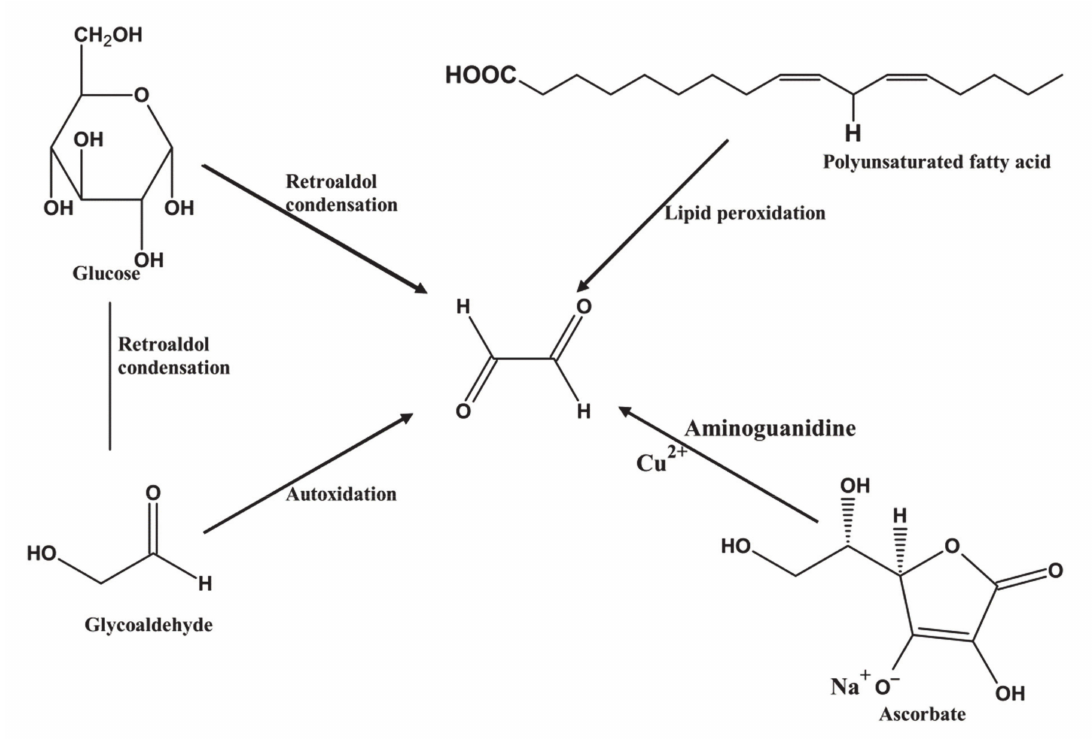
Figure 7. Synthesis of glyoxal from carbohydrate